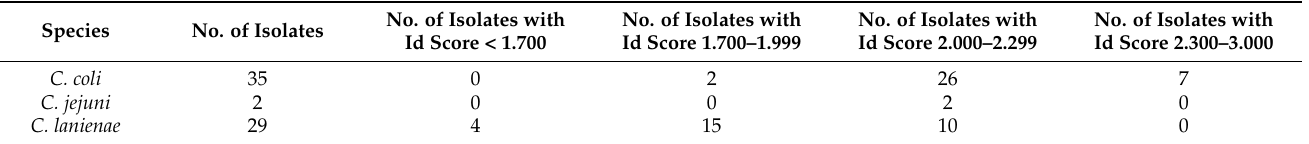
Table 4. Identification of Campylobacter isolates ( n = 66) by matrix-assisted laser desorption/ionisation– time-of-flight mass spectrometry (MALDI-TOF).